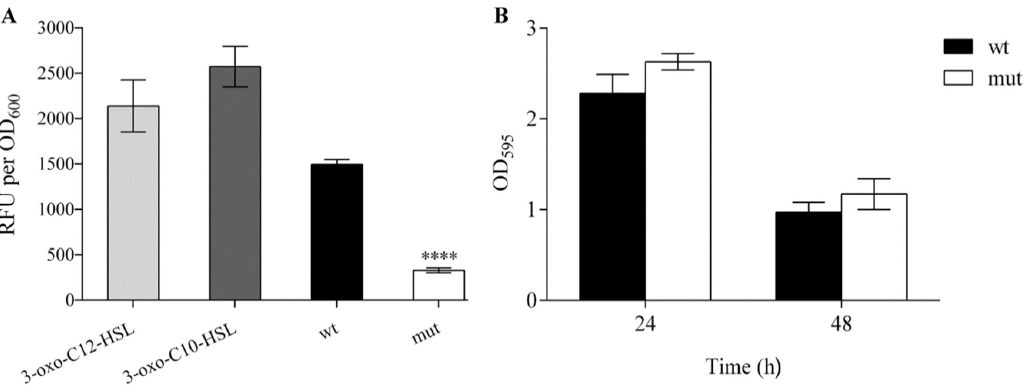
Figure 6. The effect of RclS knock-out to AHL production and biofilm formation in WCS358. ( A ) Production of AHLs by WCS358 wild type and Δ rclS mutant is represented as relative fluorescence units corrected for autofluorescence per unit of OD 600 (RFU per OD 600 ). Cell suspensions with 3-oxo-C10-HSL and 3-oxo-C12-HSL were used as a positive control. ( B ) Biofilm formation of WCS358 wild type and ∆ rclS mutant was quantified by measuring absorbance at 595 nm after 24 and 48 h of incubation. The tests were performed in sextuplicate with three independent repeats. The results are represented as mean values ± standard deviations. Student’s t -test was employed to compare differences between wild type and ∆ rclS mutant (**** p < 0.0001).